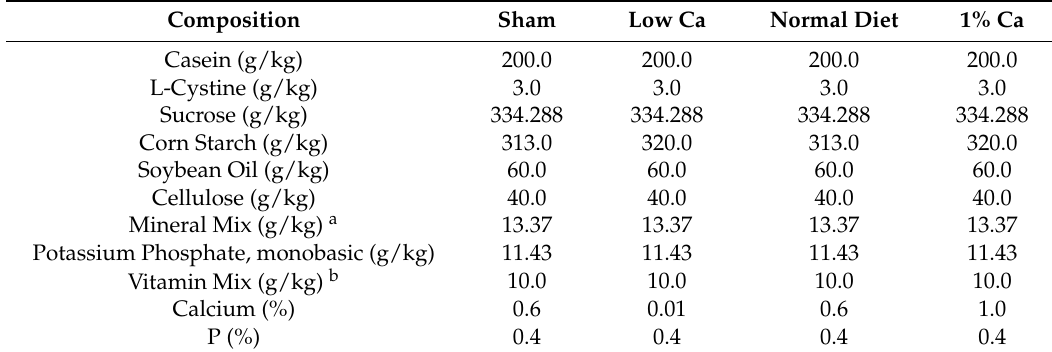
Table 1. Composition of the experimental